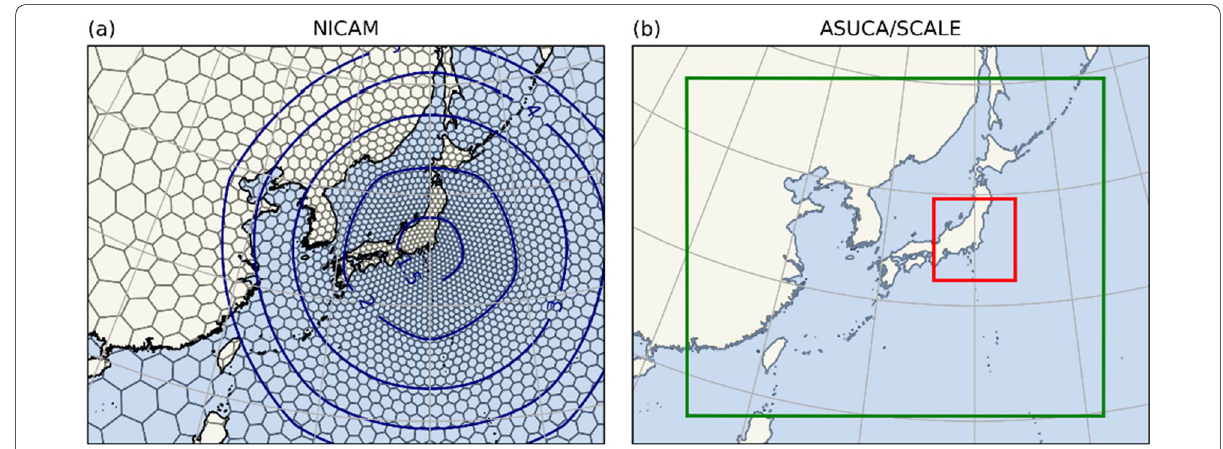
Fig. 2 a Schematic image of the grid structure of stretch-NICAM. The grid structure for g-level 4 is shown for readability. The actual grid used for the simulation is at g-level 9, whose grid can be obtained by subdividing the grid of g-level 4. Navy contours show the areas of the grid interval of g-level 9 at 1.5, 2, 3, 4, and 5 km. b The calculation domains for ASUCA for the 5 km mesh model (green) and the 1 km mesh model